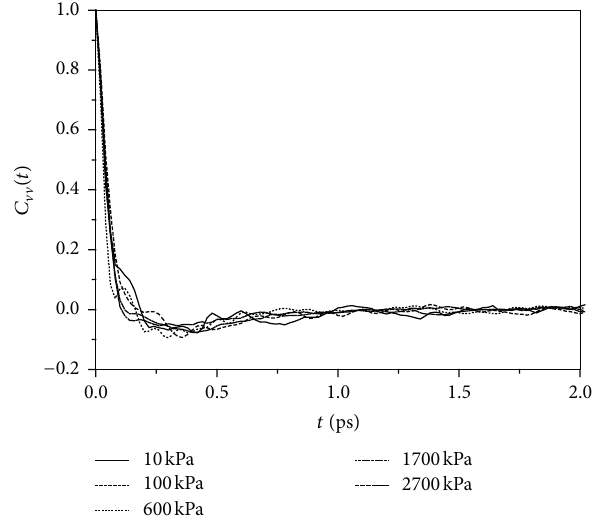
Figure 8: The velocity autocorrelation function of hydrogen molecules for the different pressure at 77 K.